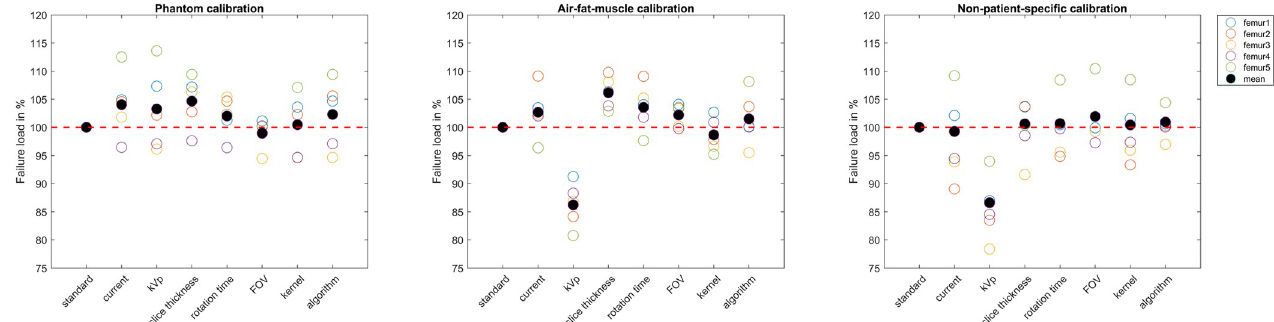
Fig 7. Failure load per protocol, per calibration method. For each femur, the failure loads are displayed relative to the standard protocol. The red dashed line indicates 100%.